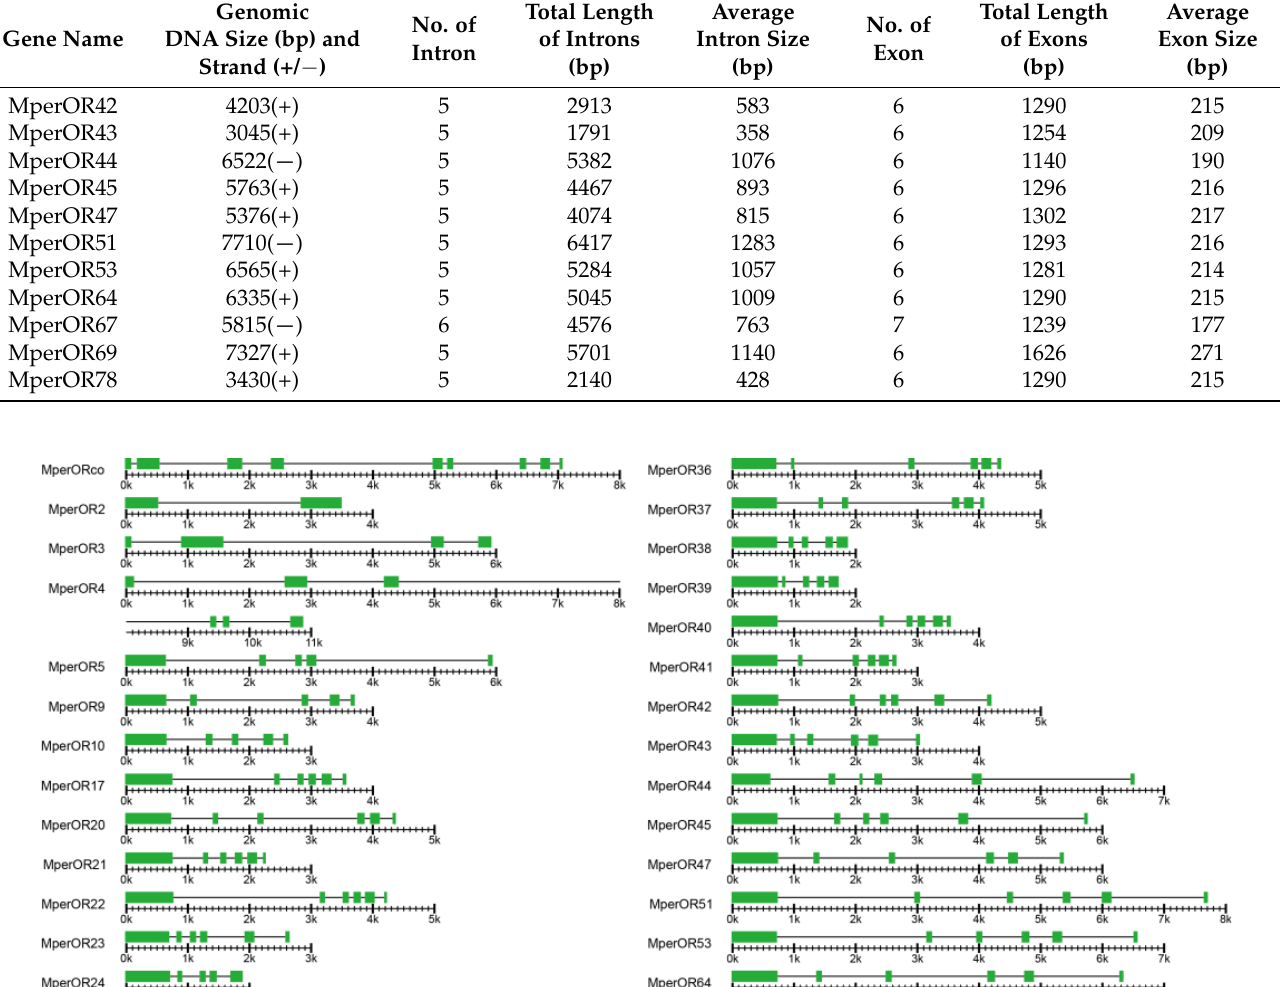
Figure 3. The tandem arrays of OR genes in M. persicae . The genomic sequences of M. persicae were downloaded from the AphidBase at the BioInformatics Platform for Agroecosystem Arthropods (https://bipaa.genouest.org/is/, accessed on 13rd May 2020)